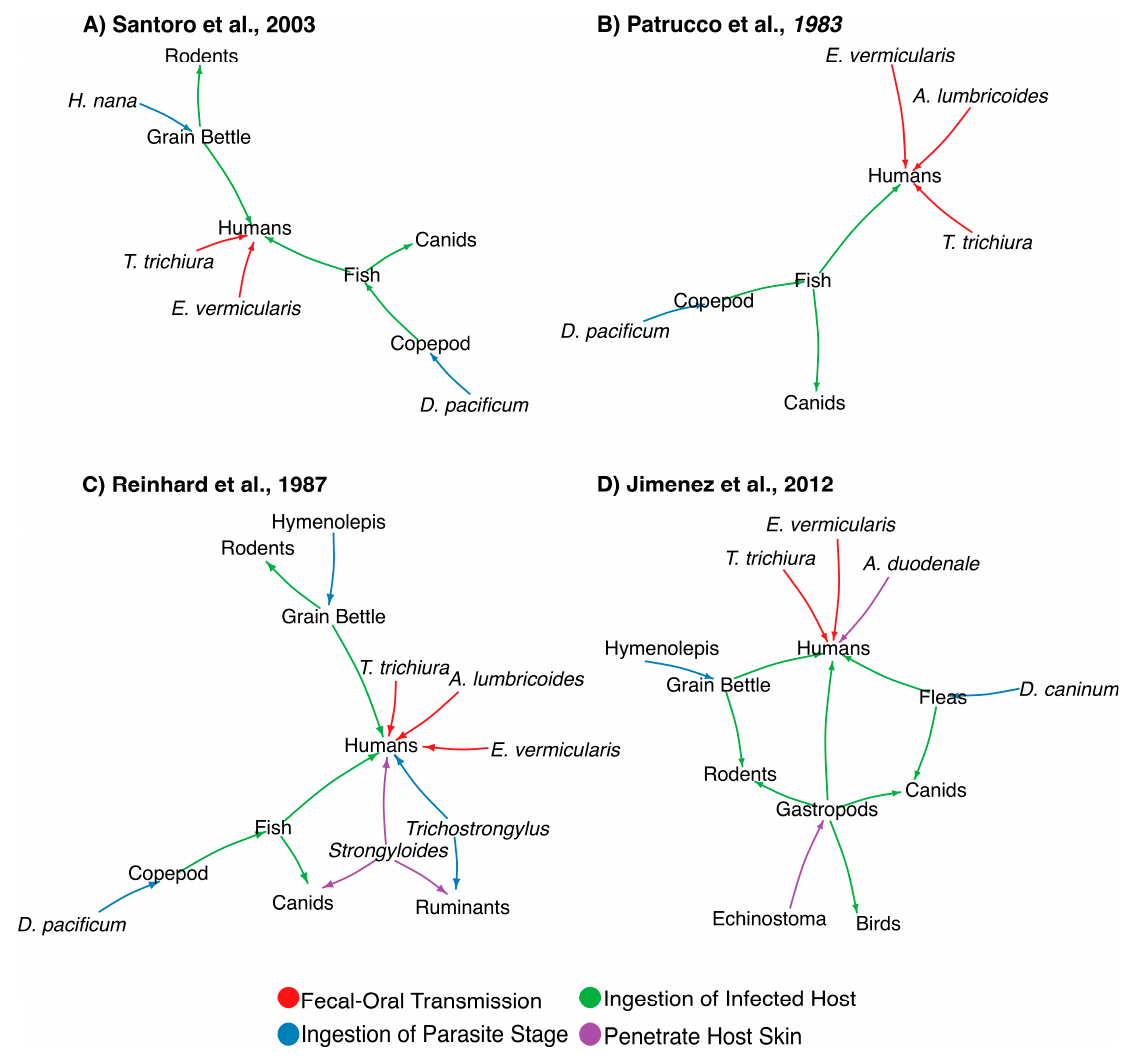
Figure 1. Network modeling representing the parasite-host interactions of pre-Columbian cultures. Networks were generated from previous studies as described by Santoro (2003) (Panel A) [63], Patrucco (1983) (Panel B) [21], Reinhard (1987) (Panel C) [15], and Jimenez (2012) [64] (Panel D) (see text). Figure was modified from [46]. Original figure was published under a Creative Commons Attribution License, which permits unrestricted use, distribution, and reproduction in any medium, provided the original author and source are credited.